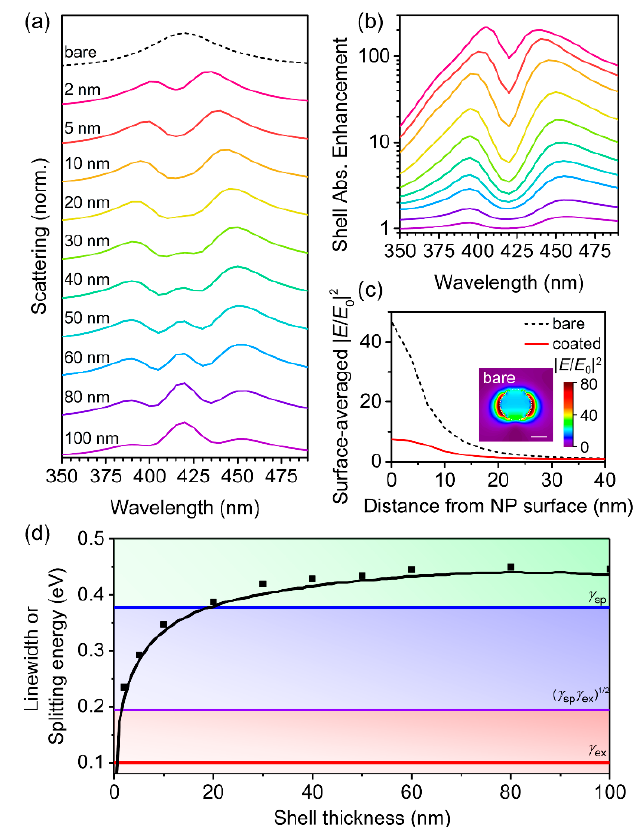
Figure 3. Variation of shell thickness, h , for core-shell structures with a single Lorentzian oscillator shell with ε ∞ = 1.77, λ 0 = 420 nm, f = 0.05, and ħγ = 0.10 eV. ( a ) Normalized scattering and ( b ) shell absorption enhancement calculated using FDTD simulations. The colors used in ( b ) are the same as those used in ( a ). ( c ) Surface-averaged electric field intensity enhancement, | E / E 0 | 2 , for a bare AgNP and a core-shell structure with h = 5 nm. Inset is the | E / E 0 | 2 enhancement profile taken from a plane parallel to the excitation polarization at λ = 420 nm (scale bar is 25 nm). ( d ) Splitting energy for hybrid plasmon–exciton modes extracted from the scattering spectra using FDTD simulations (symbols) and analytical Mie theory (black line). The background shading represents the coupling regimes (green—strong coupling; blue—intermediate coupling; red—weak coupling) as defined by the linewidths of the surface plasmon ( γ sp —blue line), the exciton ( γ ex —red line), and the relationship: √ γ γ sp ex (purple line), given in Equations (7)–(9).